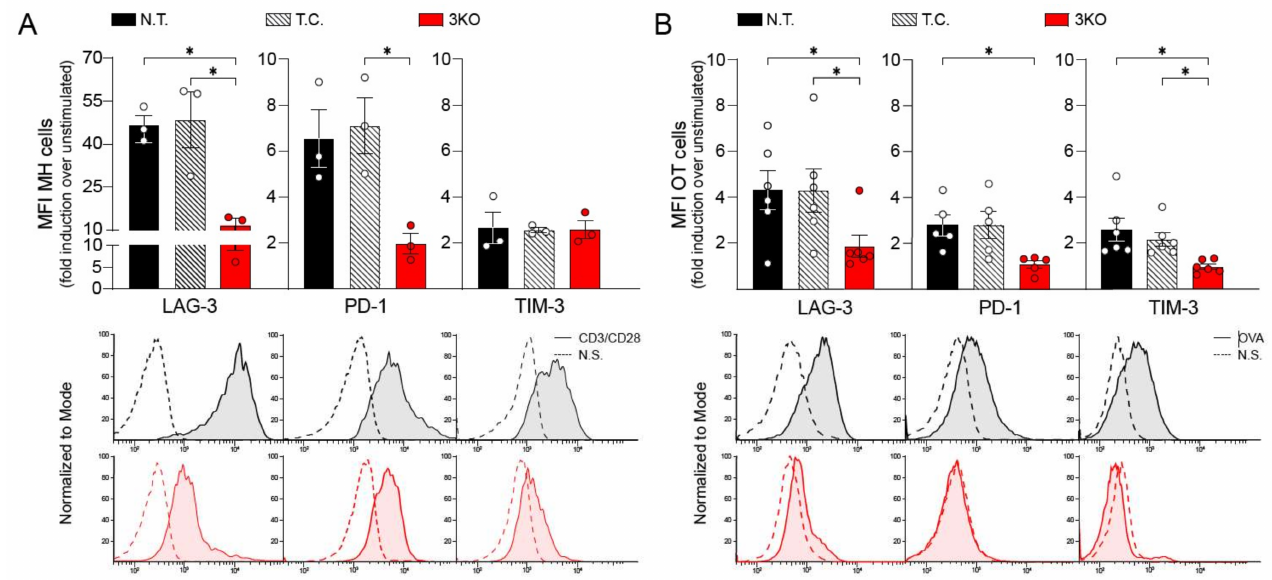
Figure 1. CRISPR/Cas9 gene editing and TIRs expression after 72 h CD8 + T cell stimulation. ( A ) Upper panel. Mean Fluorescence Intensity (MFI) of LAG-3, PD-1, and TIM-3 in MH CD8 + T cells after 72 h stimulation with anti-CD3/CD28 antibodies. Values correspond to the fold induction of CD3/CD28 stimulated MH CD8 + T cells over the unstimulated. Lower panel. Representative dot plot curves for PD-1, LAG-3, and TIM-3 intensity. Black line (straight and dotted) corresponds to N.T.; red line (straight and dotted) corresponds to 3KO. Bars are representative of three independent experiments with MH CD8 + T cells derived from three different animals. ( B ) Upper panel. Mean Fluorescence Intensity (MFI) of PD-1, LAG-3, and TIM-3 in OT-1 CD8 + T cells after 72 h stimulation with splenocytes incubated with OVA peptide. Values correspond to the fold induction of OVA stimulated OT-1 CD8 + T cells over the unstimulated. Lower panel. Representative dot plot curves for PD-1, LAG-3, and TIM-3 intensity. Black line (straight and dotted) corresponds to N.T.; red line (straight and dotted) corresponds to 3KO. Bars are representative of six independent experiments with OT-1 CD8 + T cells derived from six different animals. N.T., not transfected; T.C., transfection control; 3KO, Triple Knock Out for PD-1, LAG-3, and TIM-3 genes; N.S., not stimulated. Statistical analysis: one-way ANOVA with post-hoc test. * p <